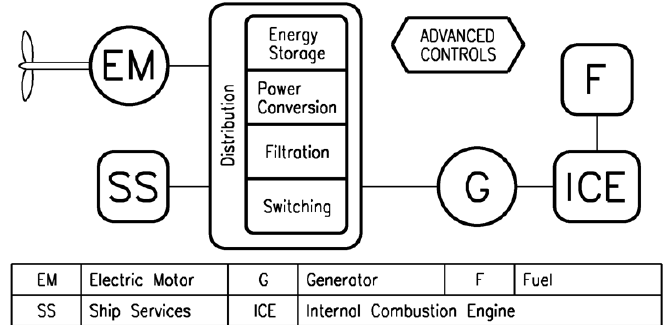
Figure 7. Integrated power and energy System architecture.